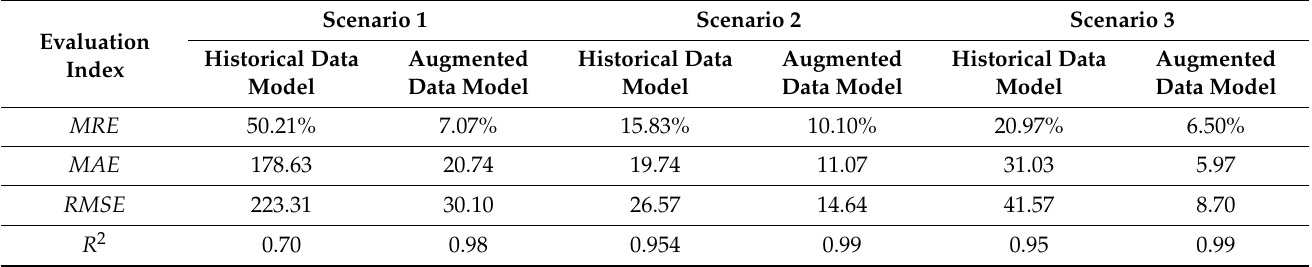
Table 5. Prediction error comparison under three application